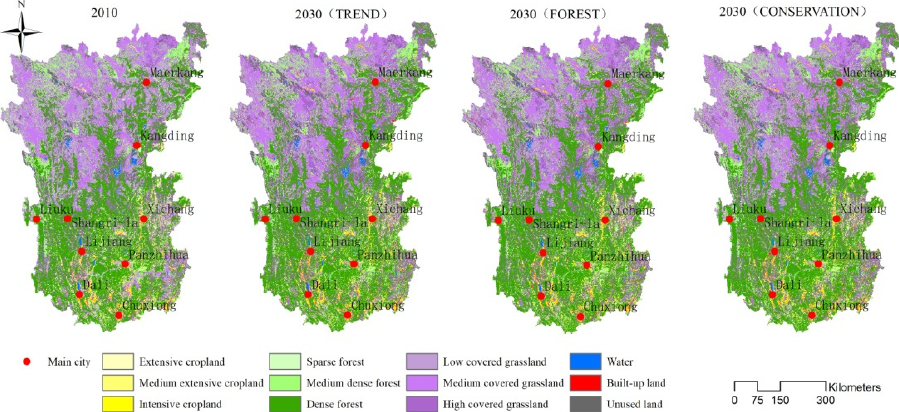
Figure 5. Spatial distribution of the land system in 2010 and different scenarios.